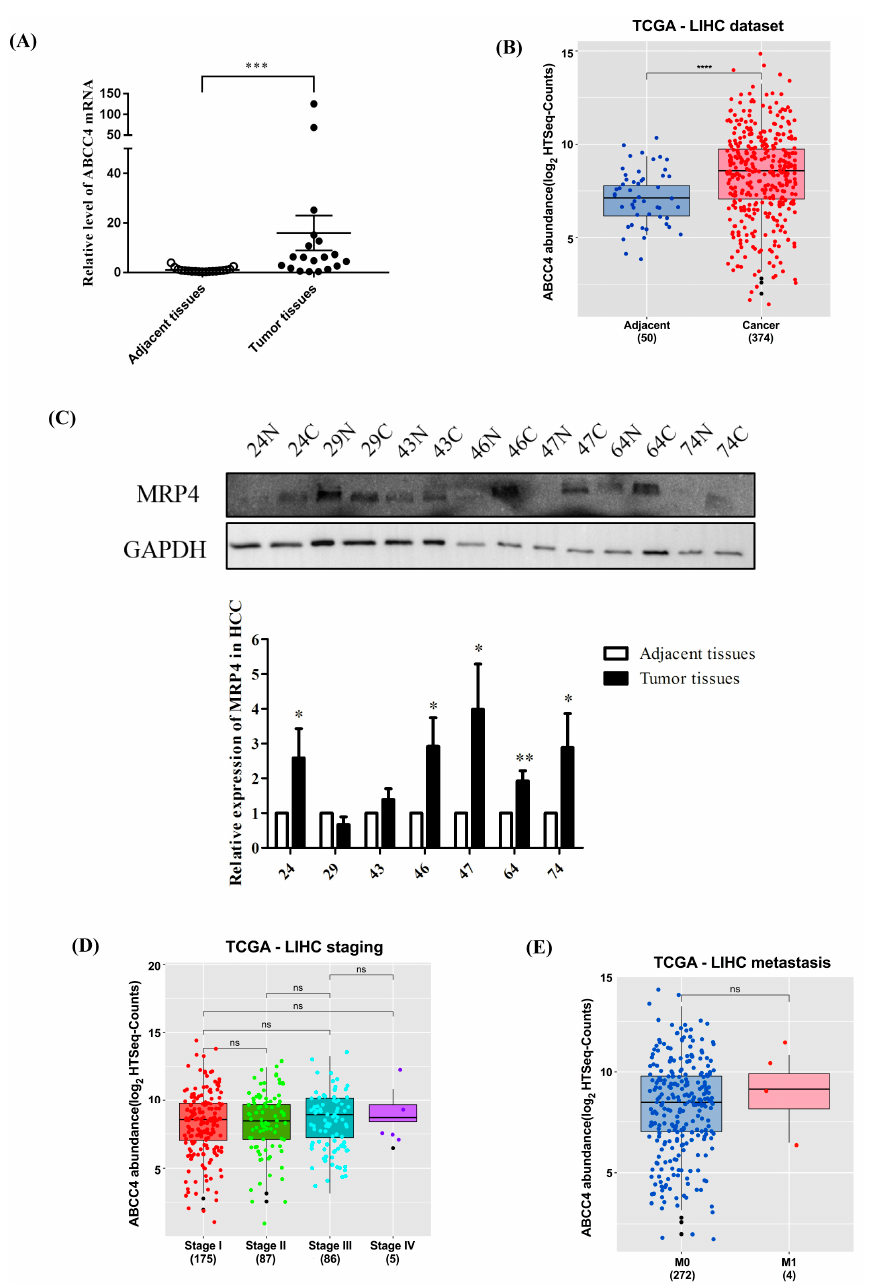
Figure 1. Multidrug resistance-associated protein 4 (MRP4) is upregulated in hepatocellular carcinoma (HCC). ( A ) The RT-qPCR results showed significant upregulation of ABCC4 mRNA in HCC tissues compared to the adjacent noncancerous tissues. Ubiquitin C (UBC) was used as reference, n = 19. Wilcoxon test was applied to detect the differences between tumor tissues and paired adjacent tissues. * p < 0.05 ( B ) ABCC4 expression levels in TCGA database ( n = 50 for adjacent group; n = 374 for cancer group). ( C ) Western blotting analyses of seven randomly selected paired tissues and the expression of MRP4 was normalized to glyceraldehyde-3-phosphate dehydrogenase (GAPDH). N, normal; C, cancer. Results are expressed as mean ± standard error of the mean (SEM) of at least three independent experiments. * p < 0.05, ** p < 0.01. ( D ) ABCC4 expression levels of different stages in TCGA database ( n = 175 for Stage I; n = 87 for Stage II; n = 86 for Stage III; n = 5 for Stage IV). ( E ) ABCC4 expression levels of nonmetastatic and metastatic HCC in TCGA database ( n = 272 for M0; n = 4 for M1). Differences between two experimental groups were analyzed by the Student’s t test., * p < 0.05, ** p < 0.01, *** p < 0.001, **** p < 0.0001. “ns” stands for not significant.